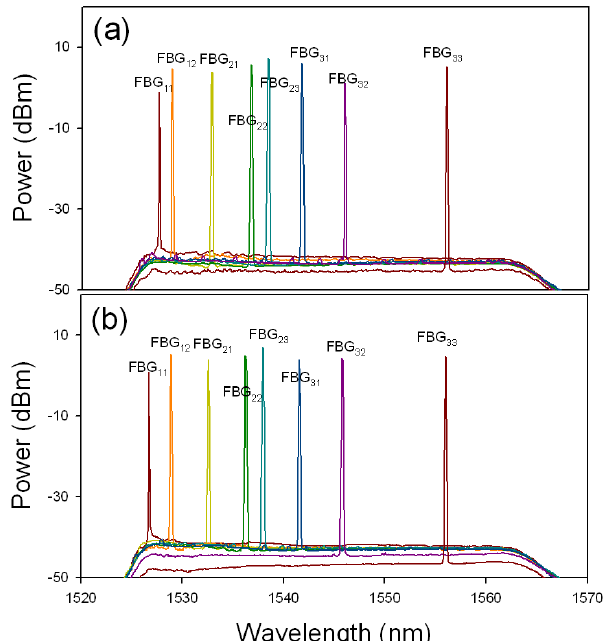
Figure 3. Output wavelengths of the proposed FBG-based sensor system from 1,527.6 to 1,556.0 nm via the (a) working and (b) protecting fiber